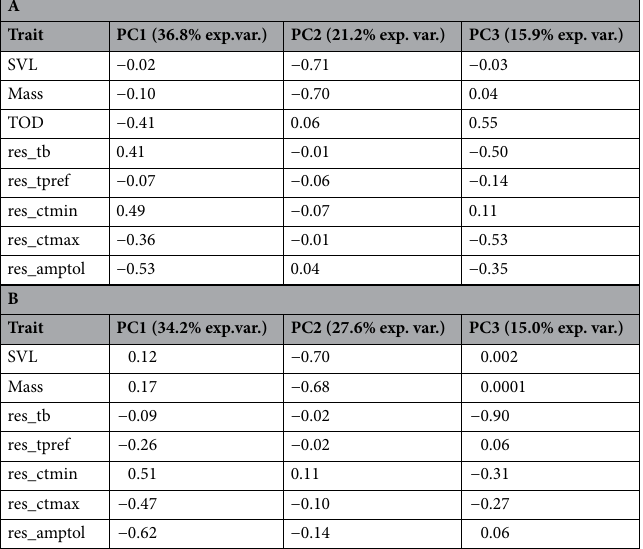
Table 6. Factor loadings of Principal Component Analysis of thermal and proxy-state related traits (A) incubation temperature and (B) age. exp. var. explained variance, Mass, body mass, res_amptol